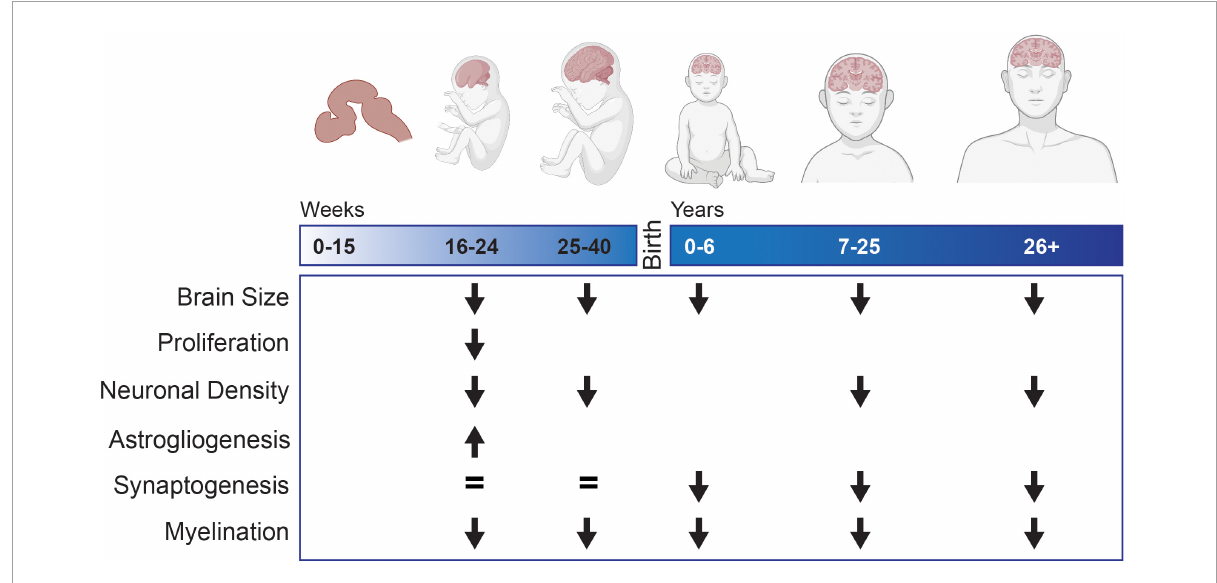
FIGURE1 Neurodevelopmental changes observed in tissue samples or MRI from individuals with Down syndrome compared to typically developing controls. Blank spaces indicate that no data exists for that developmental time